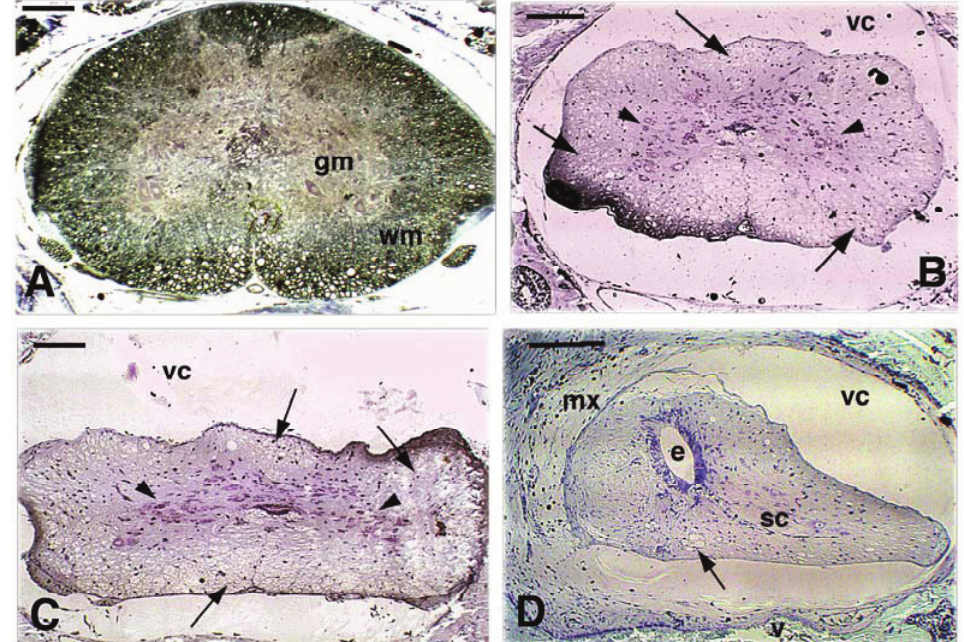
Figure 6. Representative proximal distal cross sections of spinal cord 36 days post-lesion. A , proximal spinal cord has the normal H-shape of the grey matter and numerous axons in the white matter are myelinated. Scale bar, 0.1 mm. B , a more caudal section closer to the bridge region showing a reduction in diameter and the presence of numerous degenerated axons (arrows). The arrowheads point to neurons within the grey matter. Scale bar, 20 (cid:2) m. C , a more caudal section of the proximal stump spinal cord shows a further reduction of the white matter, flattening and vacuolization (arrows) while numerous cells are present in the grey matter (arrowheads). Scale bar, 0.1 mm. D , more caudal section at the level of the ependymal ampulla that appears surrounded by few neurons and nerve fibers of the white matter. Some vacuoles (arrow) indicate degenerated areas. Scale bar, 0.1 mm. E , further caudal section in the bridge region showing a narrow spinal cord with a reduced ependymal canal (arrowhead) while the irregular white matter contains numerous glial cells and fewer neurons. Abundant scar tissue is seen between the spinal cord and the vertebral bone, probably derived from the surgical incision made to reach the spinal cord to perform the transection. Scale bar, 0.1 mm. F , close-up on the stratified ependymal epithelium present in the bridge region. Around the reduced central canal numerous stratified cells from the ependyma are seen, including dark round cells (arrowheads), pale cells (double arrowheads) representing neural or glial cells. Scale bar, 25 (cid:2) m. G , caudal section of the spinal cord stump after the bridge, showing the ependymal canal still enlarged (arrowhead) surrounded by a larger number of neurons and white matter not yet distinct into grey and white matter. Arrows indicate the larger degenerated axons. Scale bar, 0.1 mm. H , caudal most level of the distal SC stump that shows increased diameter. Arrowheads indicate the grey matter with numerous neurons, but small or large (arrow) vacuolated areas are present. Scale bar, 0.1 mm. Legends: c, central canal; e, ependyma; gm, grey matter; mx, meninx; sc, spinal cord; sco, scarring connective-meninge; v, vertebral bone; vc, vertebral canal; wm, white